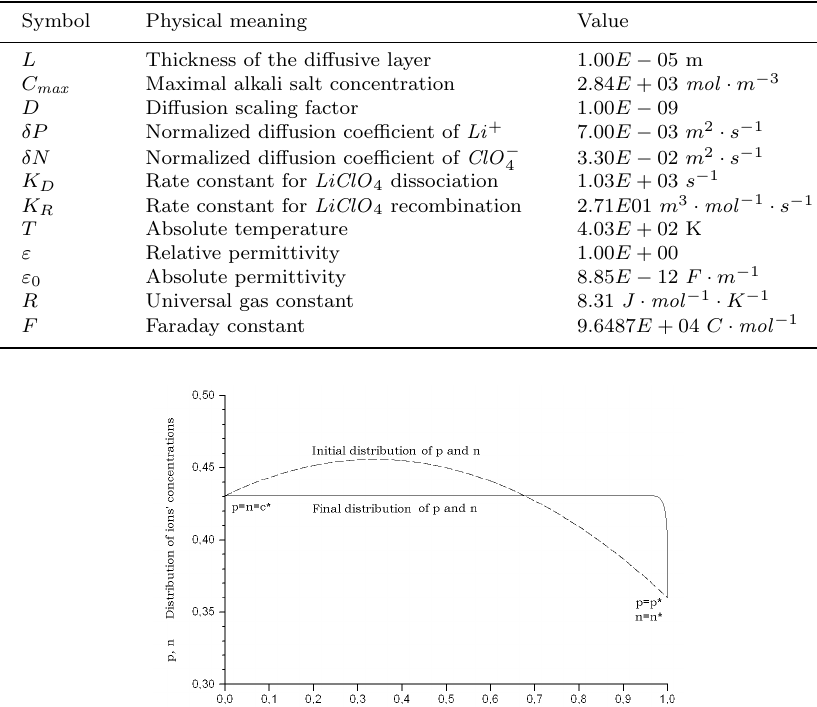
Table 1. Constants and parameter values of the model.